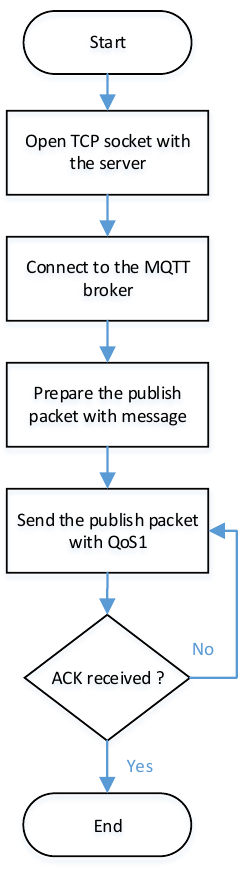
Figure 6. Flow chart of IoT